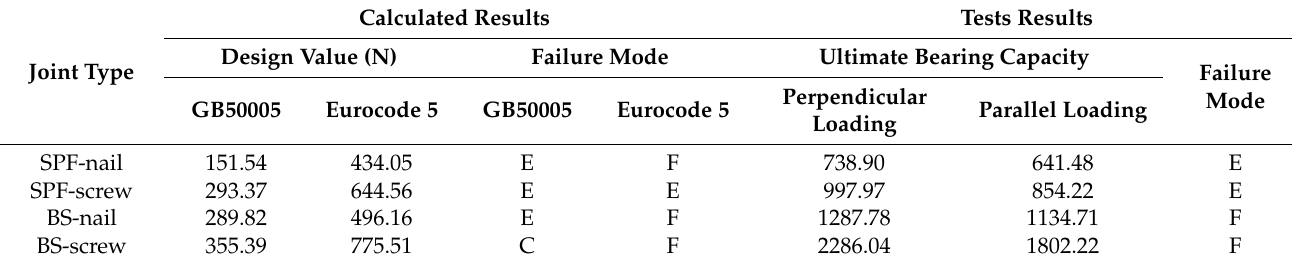
Table 4. Comparison of calculated and experimental results of